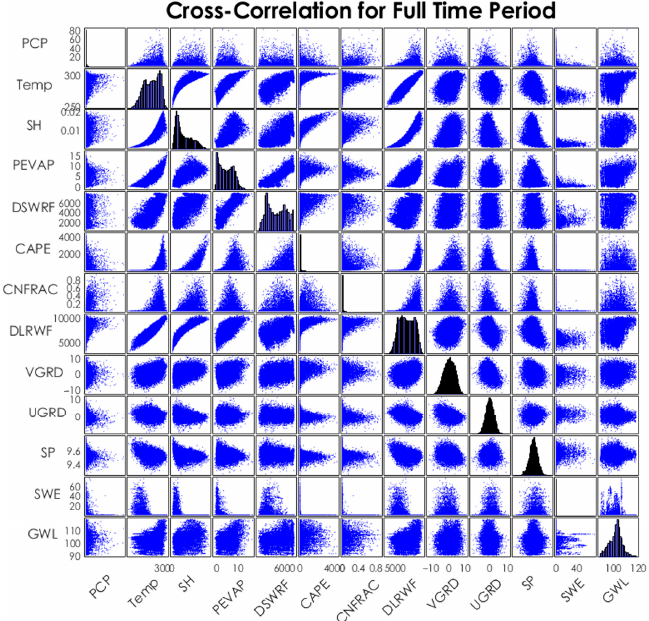
Figure A1. Cross ‐ correlation pair plot for all 13 predictive variables over the full time period (1990– 2020).